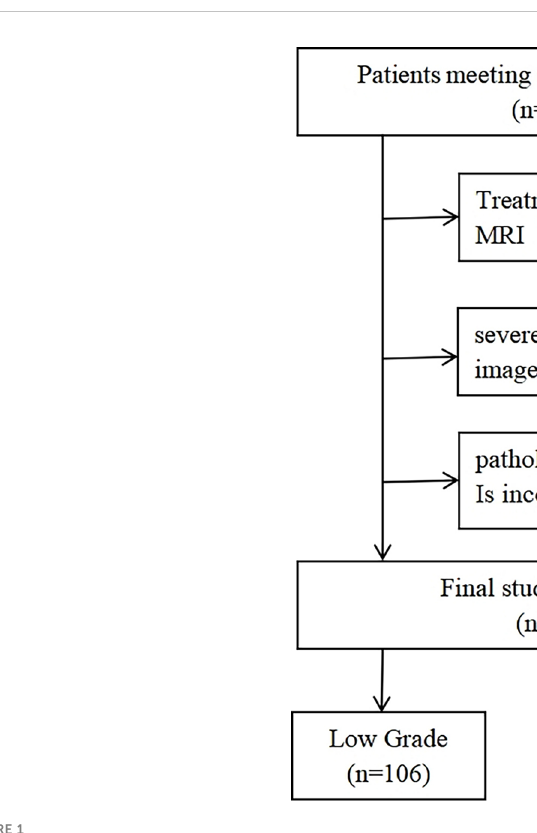
FIGURE 1 Flow diagram of patient recruitment.